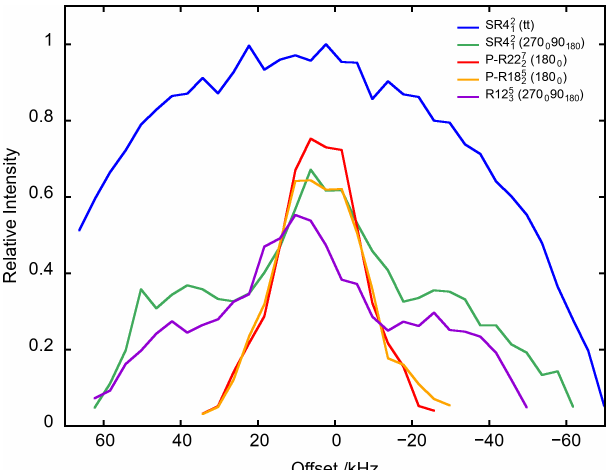
Figure 5. The 27 AlO 6 signal of γ -alumina at ν R = 20kHz as a function of offset for PRESTO-R22 7 R18 5 (180 0 ) as well as RINEPT-CWc-SR4 2 2 SR4 2 (270 0 90 180 ) and RINEPT-R12 5 1 curve, τ and ν 1 or ν 1 , max were fixed to their optimum values given in Table